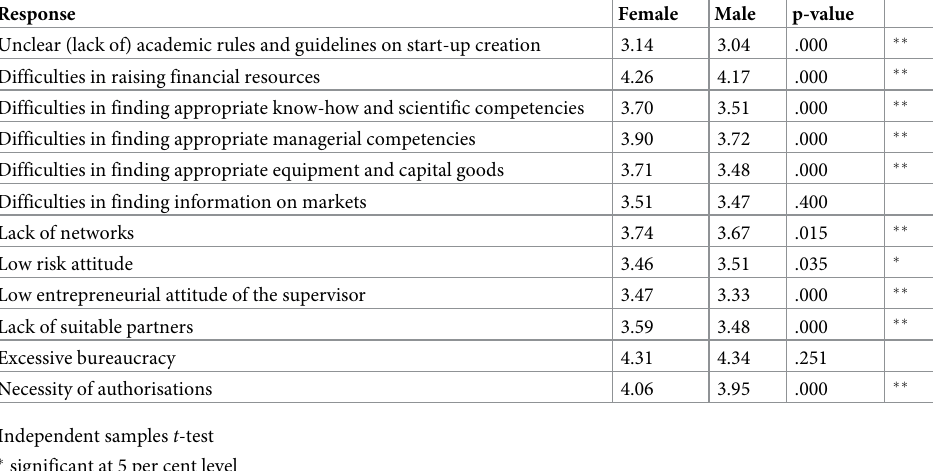
Table 2. Students’ opinion about the relevance of obstacles to entrepreneurship.